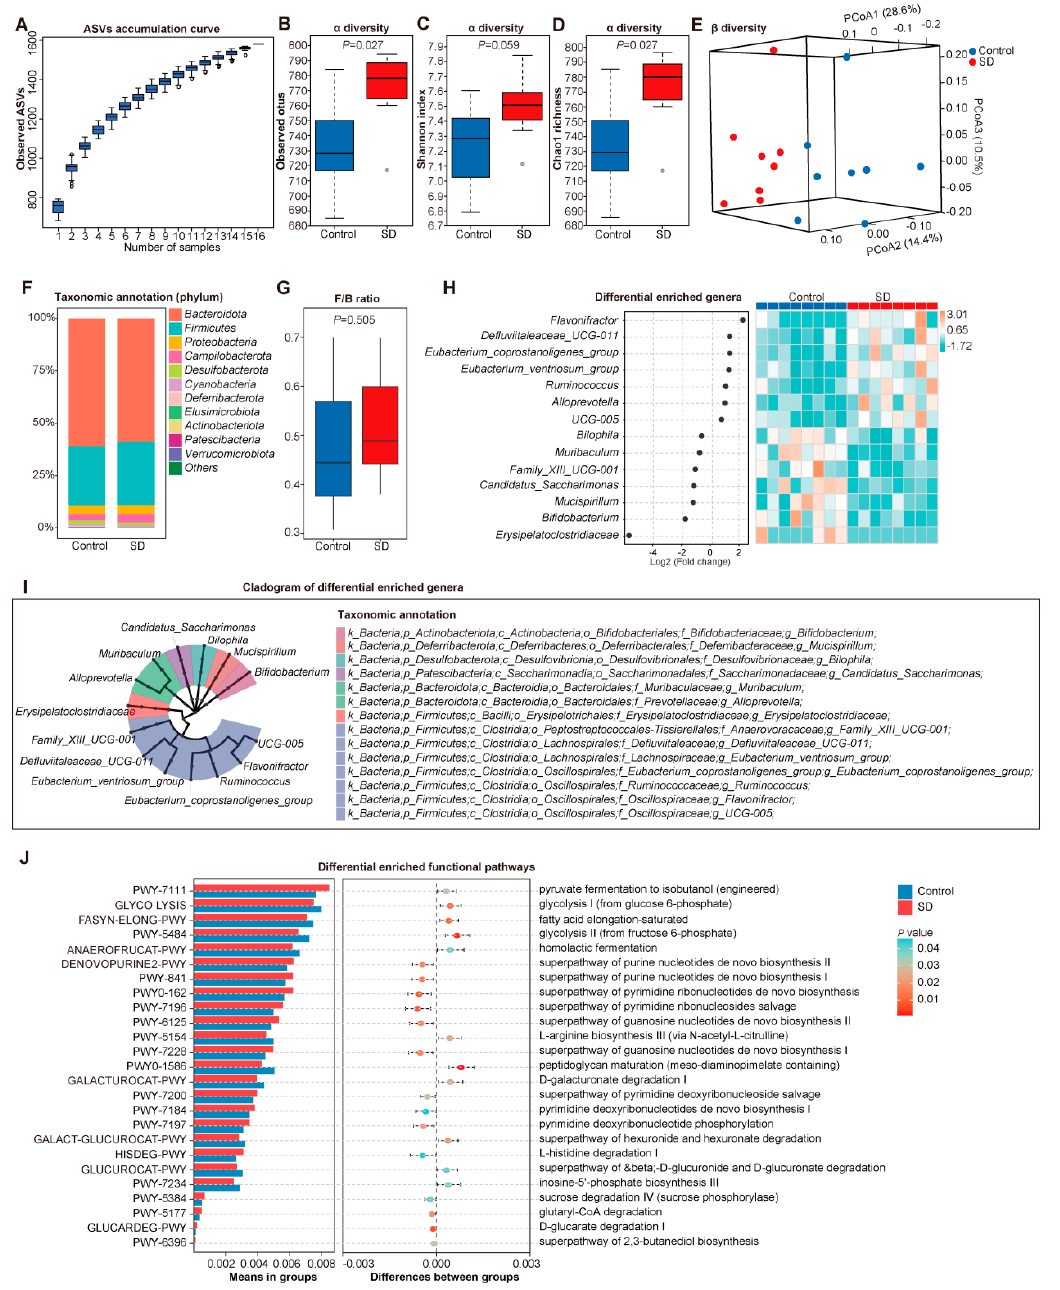
Figure 2. Altered gut microbiota in SD mice. ( A ) The ASVs accumulation curve. The observed OTUs ( B ), Shannon index ( C ), and Chao1 richness ( D ) in the control and SD group. Boxes represent the interquartile ranges; the inside line or points represent the median, and circles are outliers, Kruskal– Wallis test. ( E ) Principal coordinates analysis (PCoA) based on Bray–Curtis distance. The green circles represent control, and the purple circles denote SD. ( F ) Phylum-level taxonomic abundance and proportion for the control (left) and SD (right) groups; different taxa are differentiated by color. n = 8 for each group. ( G ) The ratio of the Firmicutes to Bacteroidetes (F/B ratio) in the control and SD groups. ( H ) Differential enriched genera between control and SD group, t -test. ( I ) The cladogram of differential enriched genera. ( J ) Differential enriched functional pathways between control and SD group, t